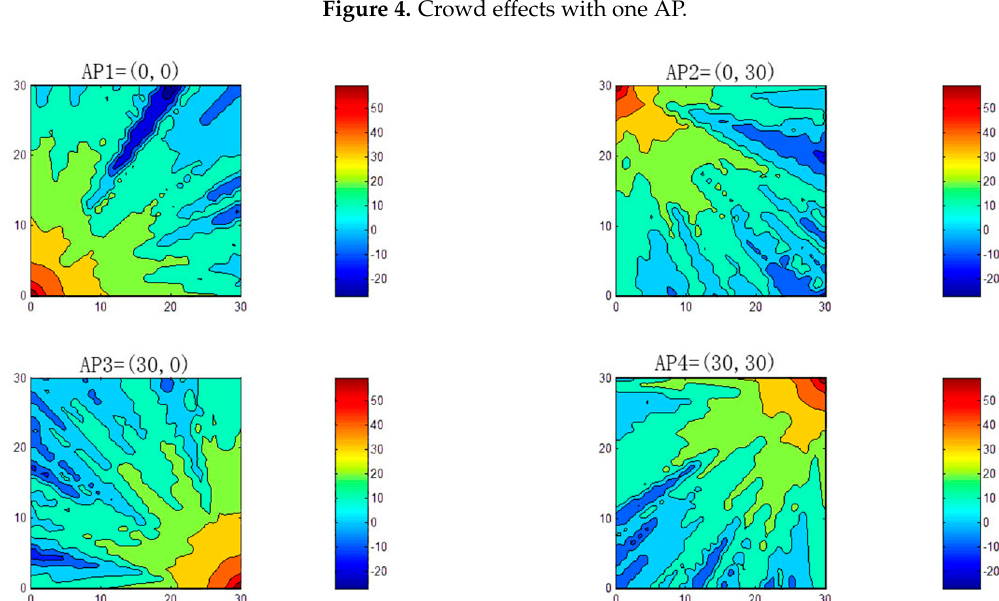
Figure 5. WAF relationship among APs; AP1 is in the upper left, AP2 is in the upper right, AP3 is in the lower left, and AP4 is in the lower right.